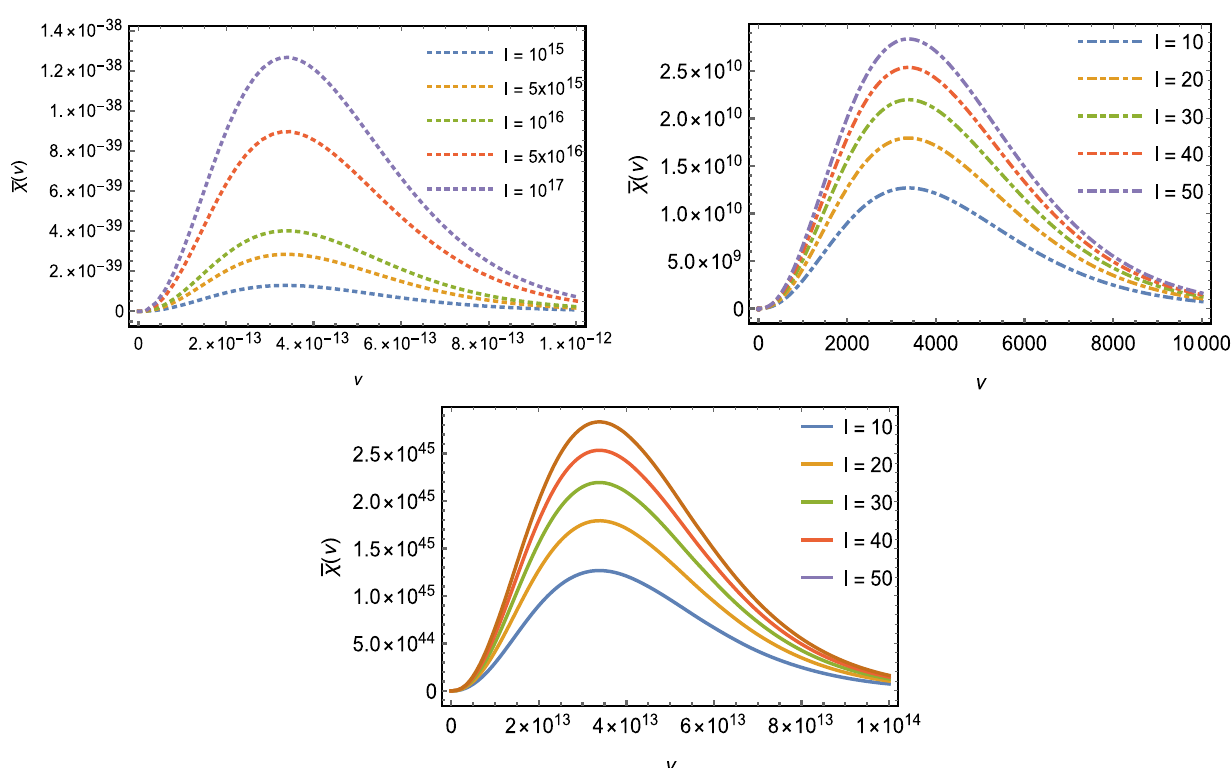
is ascribed to the electroweak configuration, i.e., β = 10 − 3 GeV; the bottom plot shows the black body radiation to the inflationary period of the Universe, i.e., β = 10 − 13